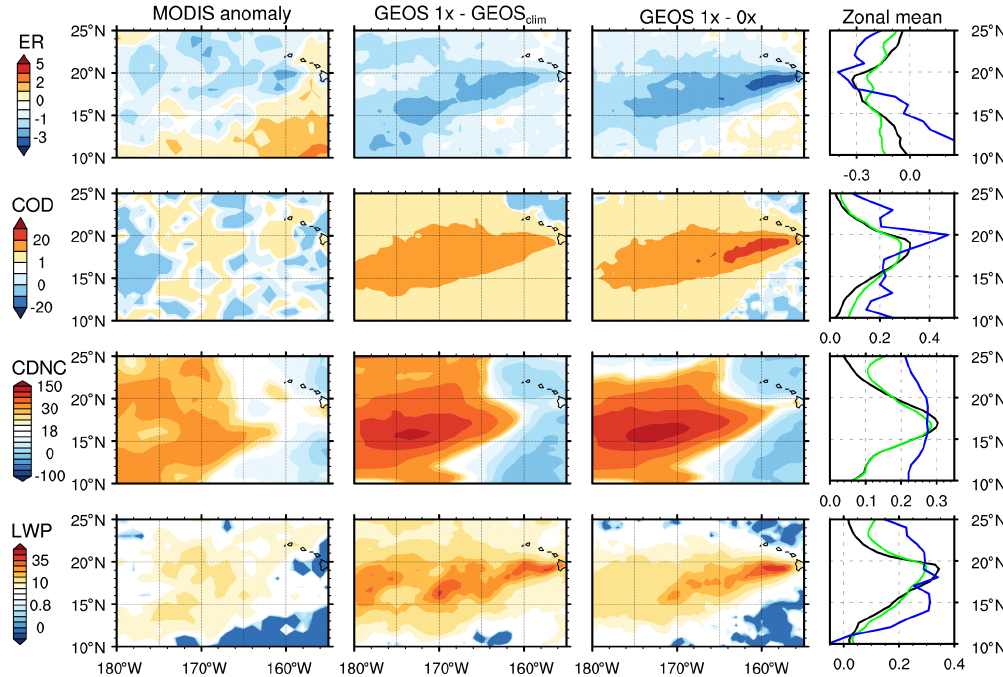
Figure 7. Like Fig. 6 but for MJJ